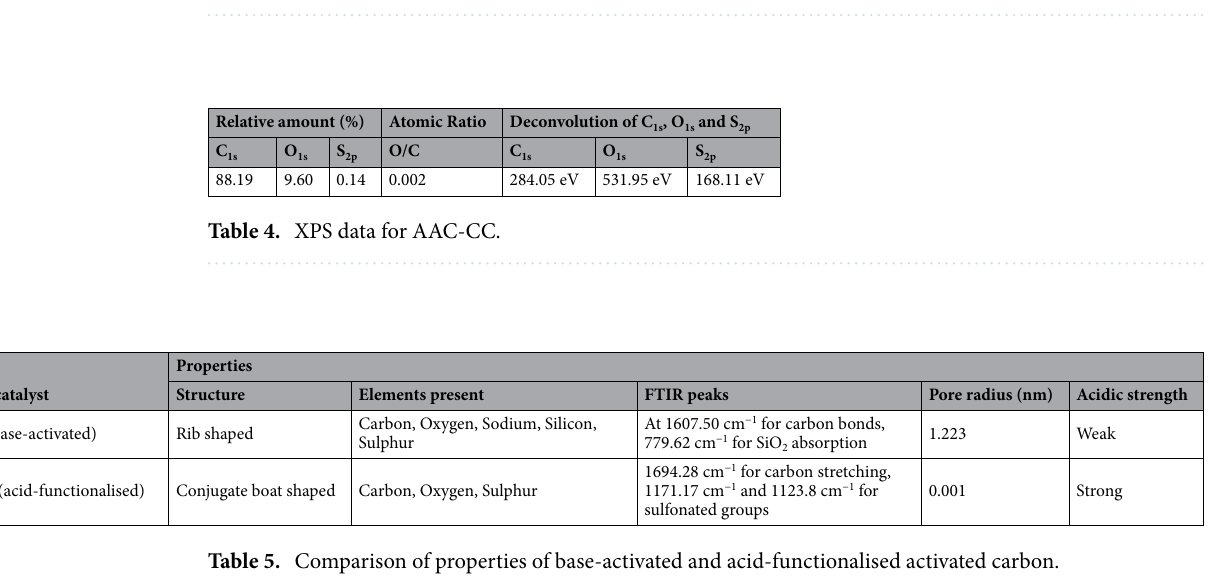
Figure 8. Deconvolution of ( a ) Carbon, ( b ) Oxygen, ( c ) Sulphur and ( d ) XPS spectrum.